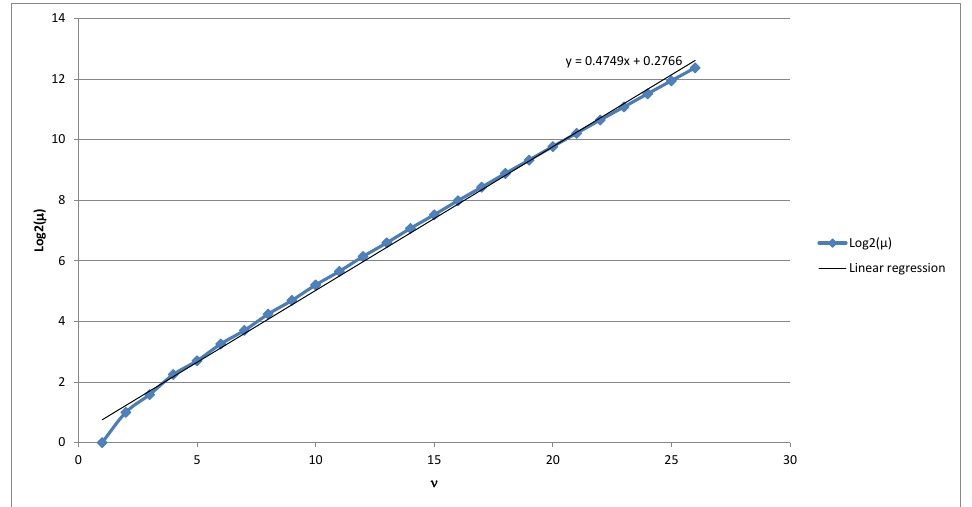
Figure 4. Linear regression for log